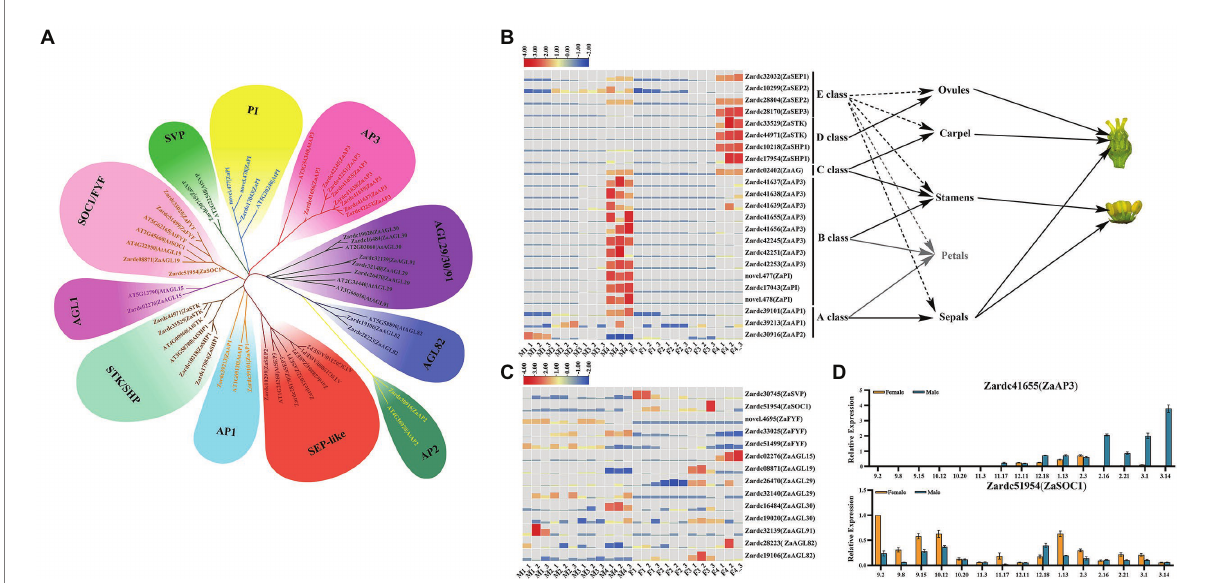
FIGURE 6 The identification of DEGs associated with MADS-box transcription factors. (A) The phylogenetic analysis of MADS-box DEGs screened in the male vs. female samples. (B) The heat map of DEGs related to ABCDE model. Due to the deletion of petals in Z. armatum , its related information was shown as gray color. (C) The heat map of DEGs involved in the transition from vegetative to reproductive growth. (D) The relative expression of two DEGs during 15 male and female floral